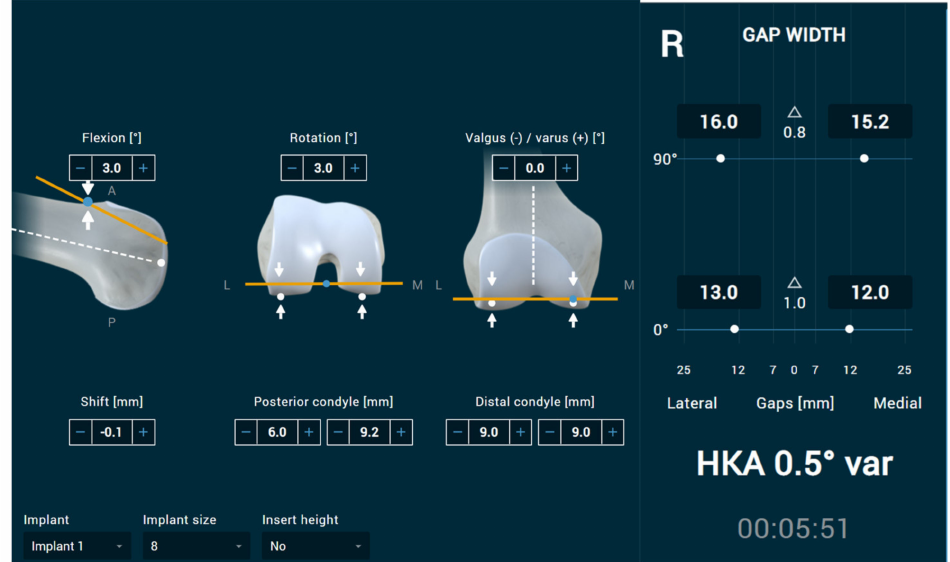
Figure 2. User interface of the femoral planning/decision monitor. All reference points are shown as blue dots. All parameters on the left side are directly linked to extension and flexion gap